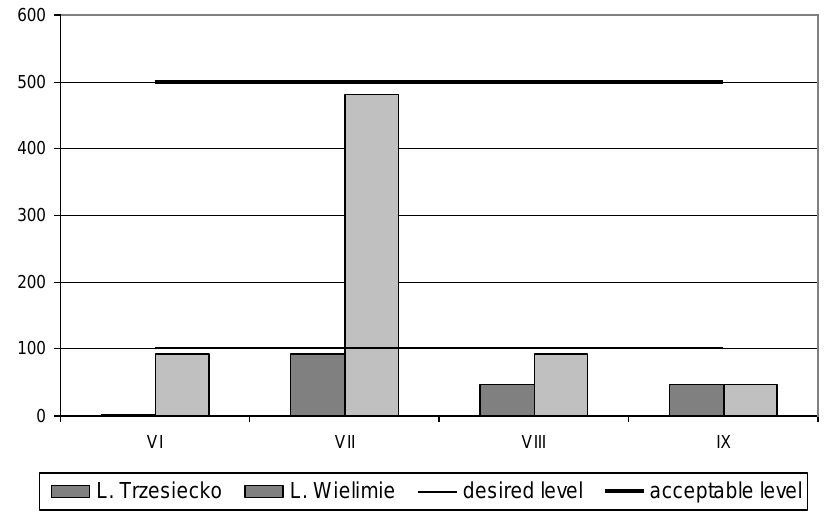
Fig. 3. Number of E. coli bacteria [jtk] in 100 ml water Table 2. Number of E. coli bacteria in the surroundings of the lakes [jtk/100 ml deposit]